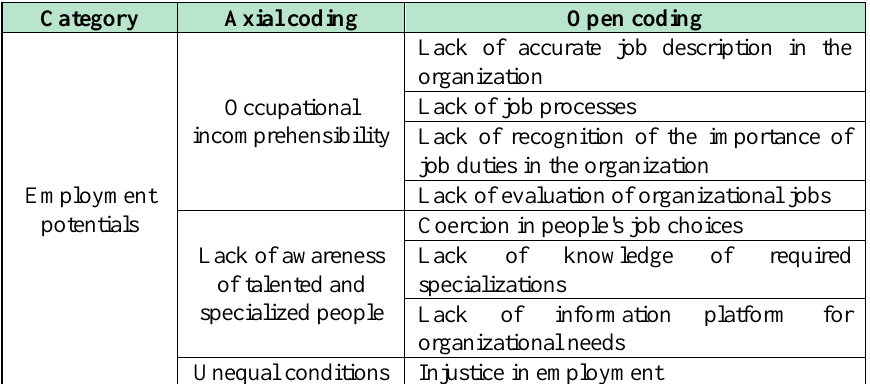
Table 1 - Open coding of qualitative data (casual